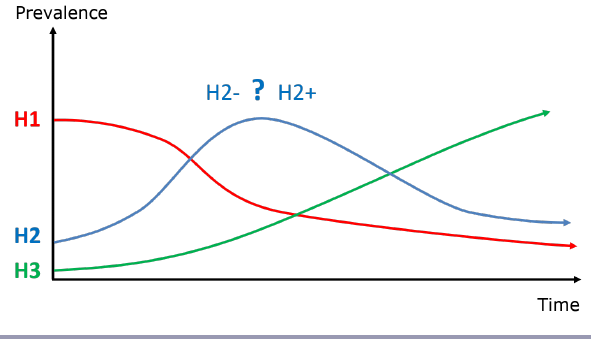
Fig. 2 . Three Horizons. “Prevalence” refers to the extent to which a particular pattern dominates the issue of concern (e.g., way of doing things, use of a particular technology, set of values). These patterns change over time. H1 is a current, declining, pattern. H3 represents an emerging future pattern. H2 is the turbulent domain of transitional activities and innovations which people are trying out in response to the changing landscape between H1 and H3. Importantly, each way of doing things is present at all times, albeit to a greater or lesser extent. H2- and H2+ highlight that innovations emerging in H2 can either be subsumed back into H1 or go on to create the space for, and emergence of,